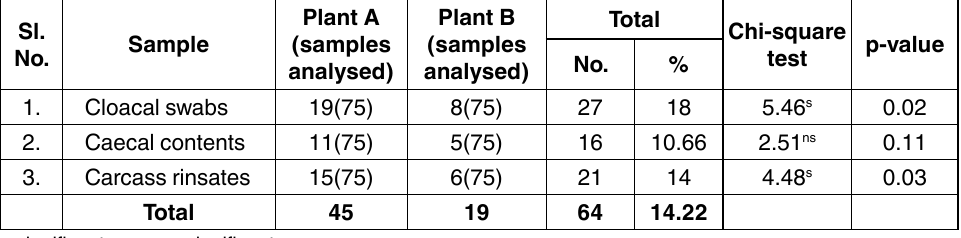
table 2 . Overall occurrence of Salmonella spp. by conventional culture technique